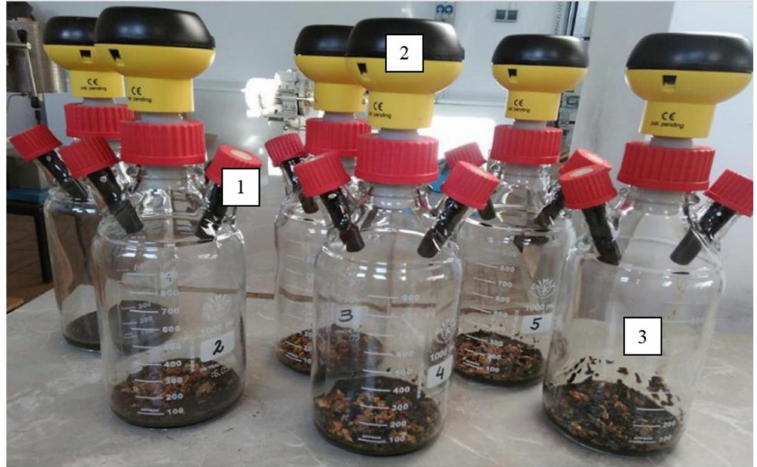
Figure 2. Biogas production from a mixture of BSG, biochar produced via torrefaction of BSG, and digestate inside an OxiTop Control AN6 system. Replicated trials were conducted for 21 days at 37 ◦ C. 1 —side connectors, 2 —manometric head with a pressure sensor and data storage, 3 —sealed glass